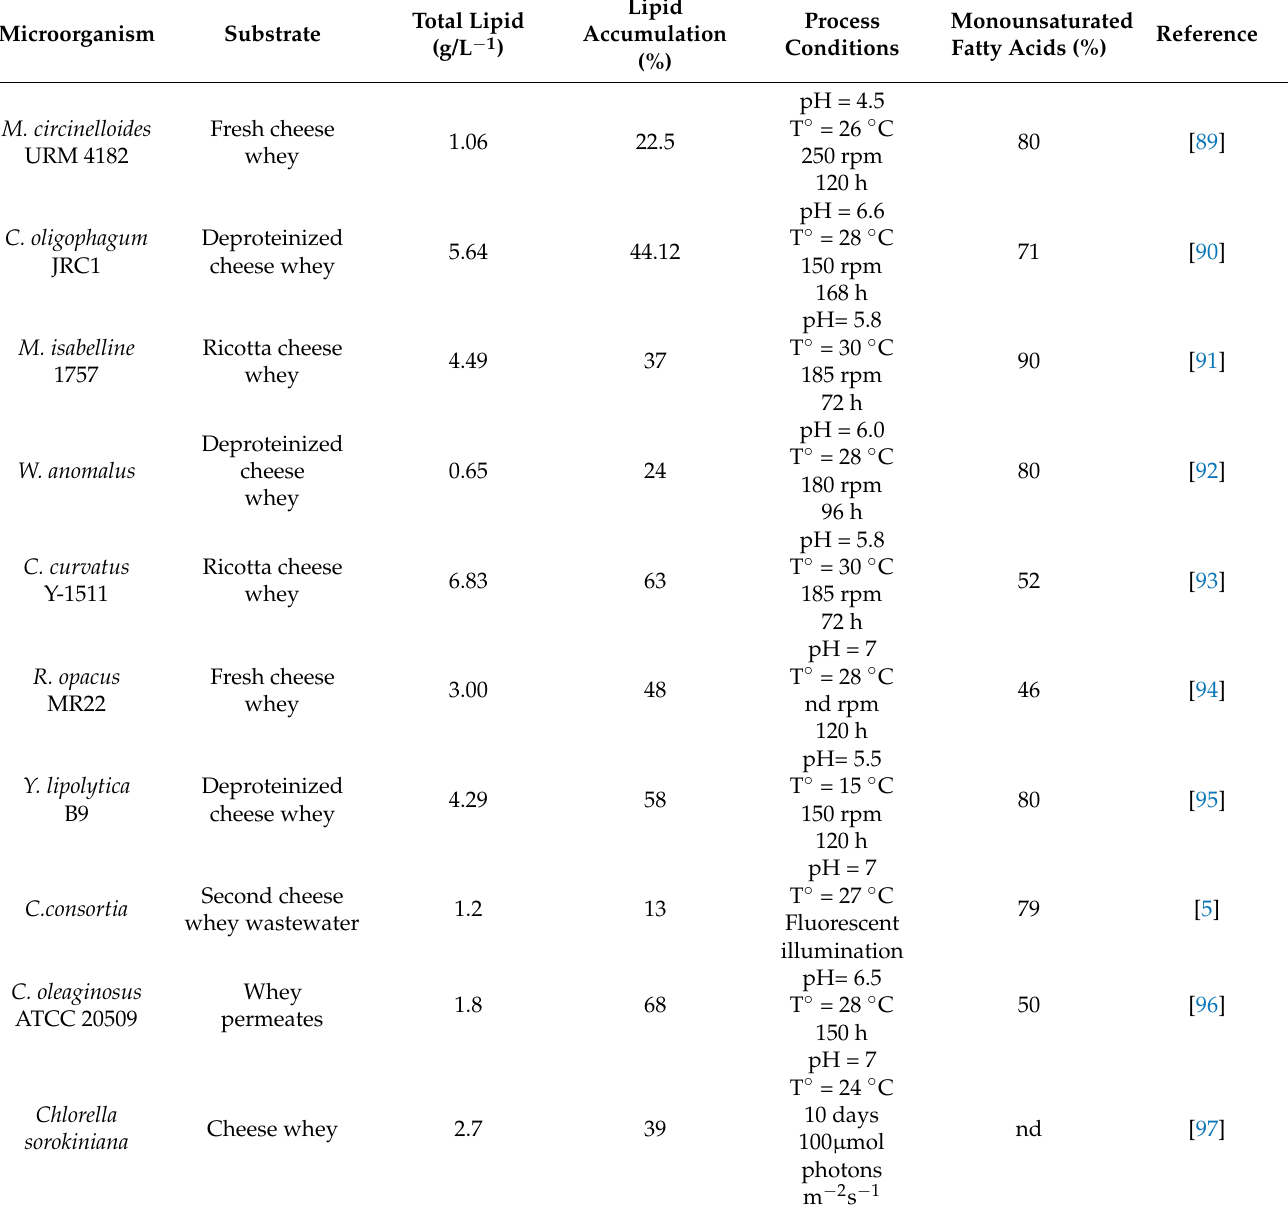
Table 5. Main lipid-producing microorganisms use cheese whey as a